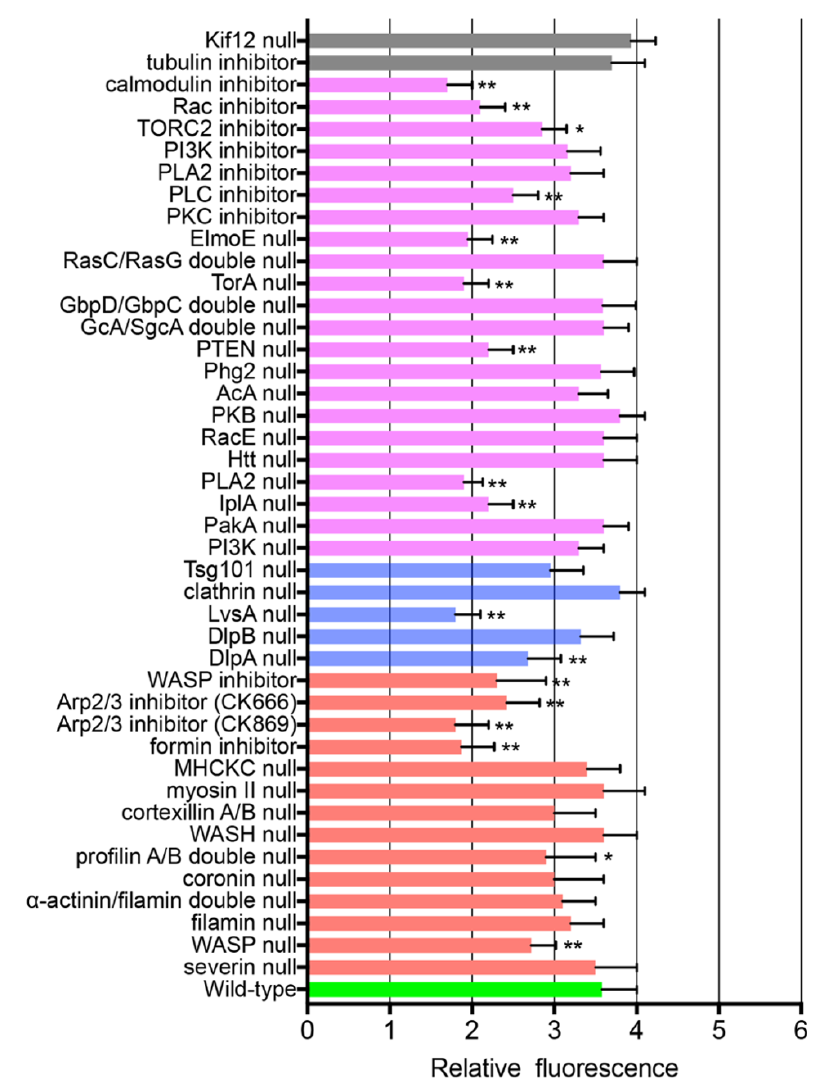
Figure 5. Peak amplitudes of wound-induced actin dynamics in null cells or wild-type cells in the presence of inhibitors. The amplitudes at the peaks of the actin dynamics under the same conditions as shown in Figure 4. Actual time courses of the fluorescence intensities are shown in Supplementary Figures S3 and S4. Asterisks show cases with significant differences from wild-type cells in the absence of inhibitors. Data are presented as means ± SD. * p ≤ 0.001, ** p ≤ 0.0001 ( n ≥ 25 each).